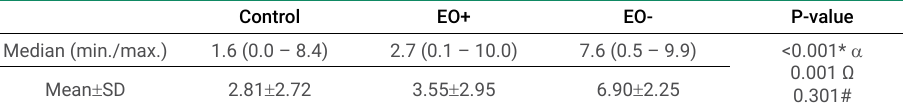
Table 2. Gustatory perception after a single rinse with essential oils with alcohol, without alcohol, and control substance. Control EO+ EO- P-value Median